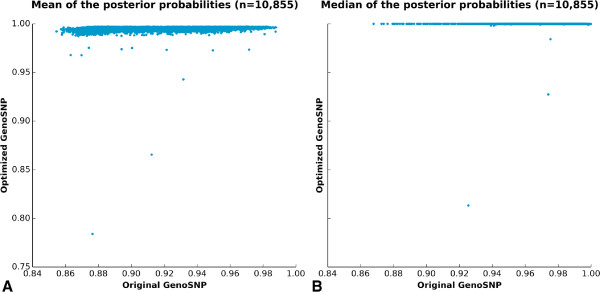
GenoSNP clustering quality. Quality assessment of GenoSNP’s clustering for original (x axis) against optimized (y axis) parameters. For each sample, both the (A) mean and the (B) median of the posterior probability of all markers are shown. Each point represents a sample. A good clustering has a mean and a median calling probability close to one.